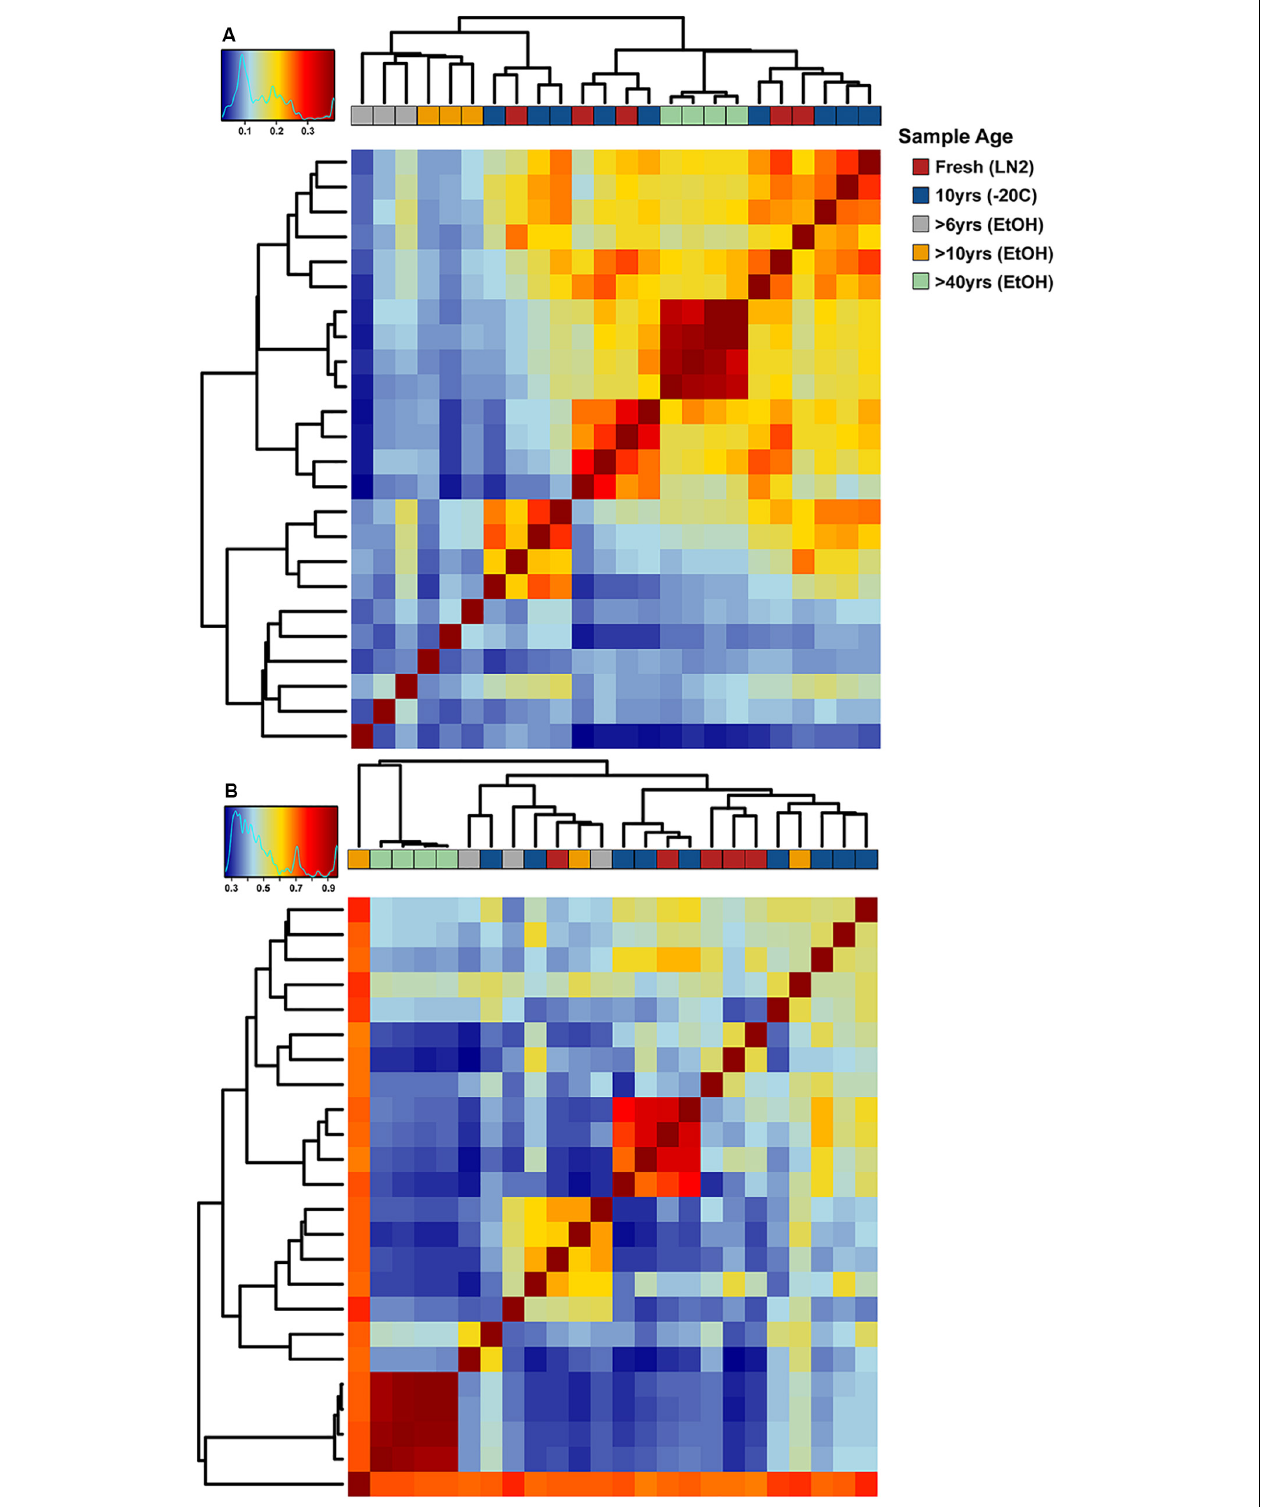
FIGURE 6 | Hierarchical clustering-based heat maps of OTU based (A) unweighted and (B) weighted Unifrac distances depicting bacterial beta diversity of intestinal samples of varying age. Dendrograms depict relatedness of samples based on intestinal bacterial community composition at the OTU level, heat map indicates level of relatedness, where red indicates a positive correlation and blue a negative correlation.